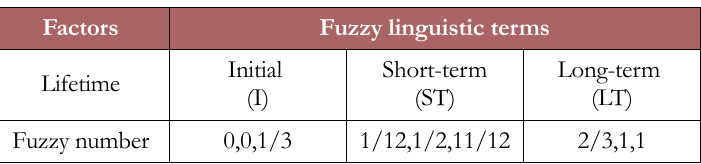
Table 2. Fuzzy linguistic variable assignment for L